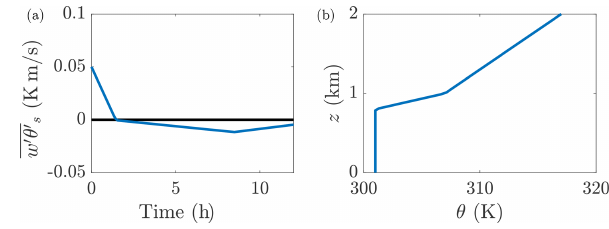
Figure B1. (a) Time-varying surface heat flux w (cid:48) θ (cid:48) s . The simu- lation is initialized at time t = 0 corresponding to 18:00. Positive heat flux corresponds to surface heating, and negative flux is cool- ing. (b) Initial potential temperature θ profile.